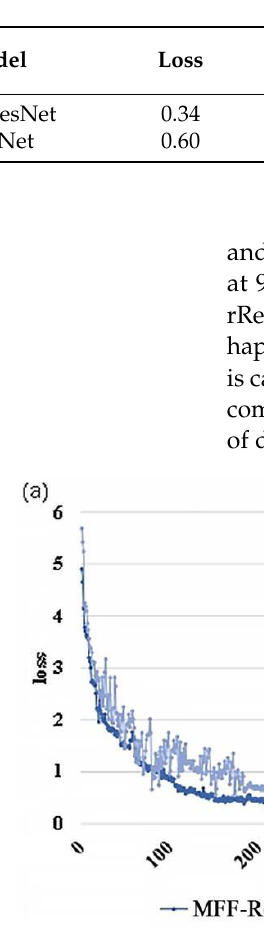
Table 2. Performance comparison under low sample complexity based on the LSE dataset.